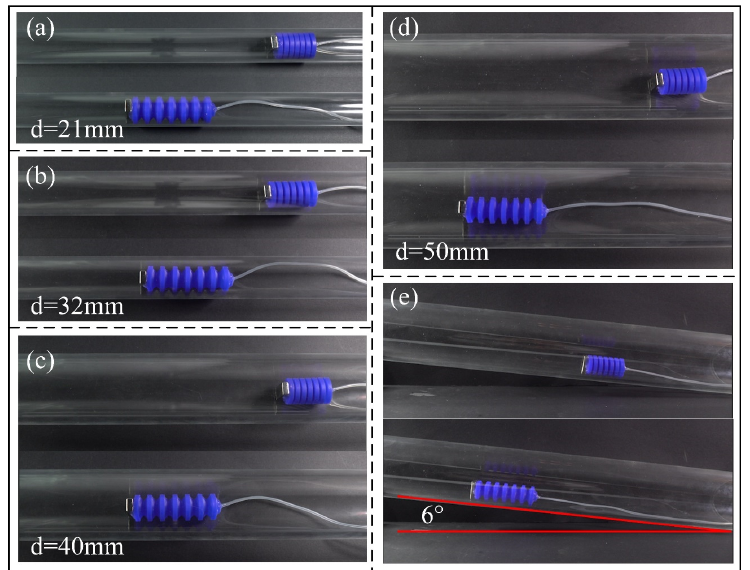
Figure 9. The crawling performance of pipelines with different diameters and slope ( a ) The inner diameter of 21 mm; ( b ) The inner diameter of 32 mm; ( c ) The inner diameter of 40 mm; ( d ) The inner diameter of 50 mm; ( e ) The slope angle with 6°.